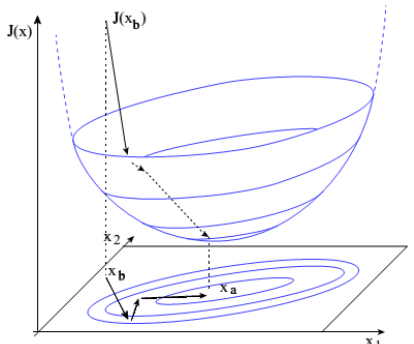
Figure 4. Minimization of cost function and its gradient. The shape of   x J